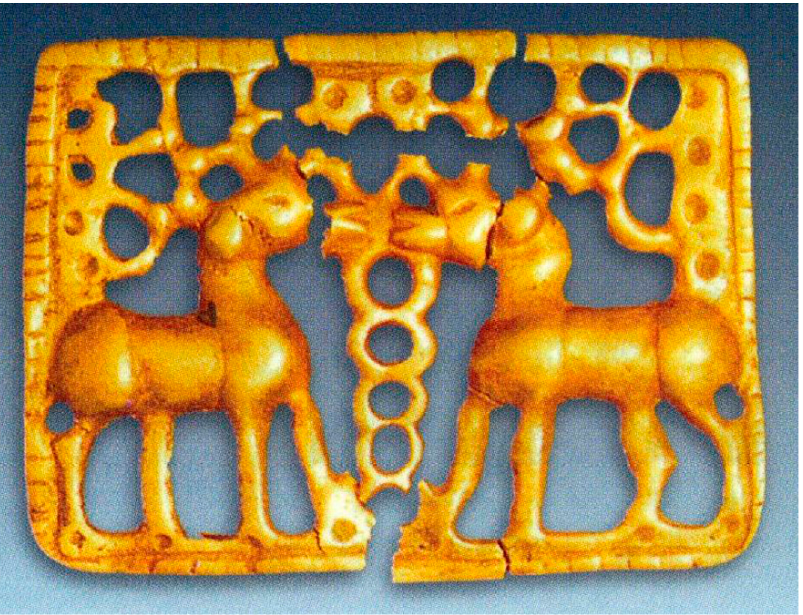
Figure 3. Twin-deer plaque, gold, 7.1 × 5.3, excavated from Sandaowan Cemetery, Qahar Right Rear Banner, Inner Mongolia; after (Wei 2004), plate 4.3. Banner, Inner Mongolia; after (Wei 2004), plate